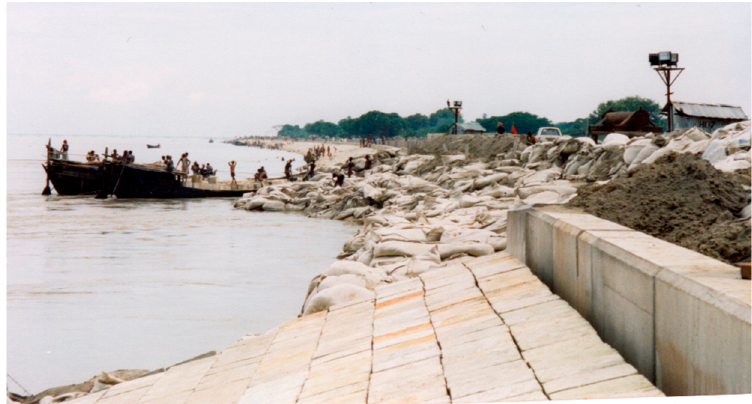
Figure 3. Repair of a scar in the Sirajganj New Town Protection after a flow slide using sand-filled geotextile bags in 1997 (photograph taken by the author).